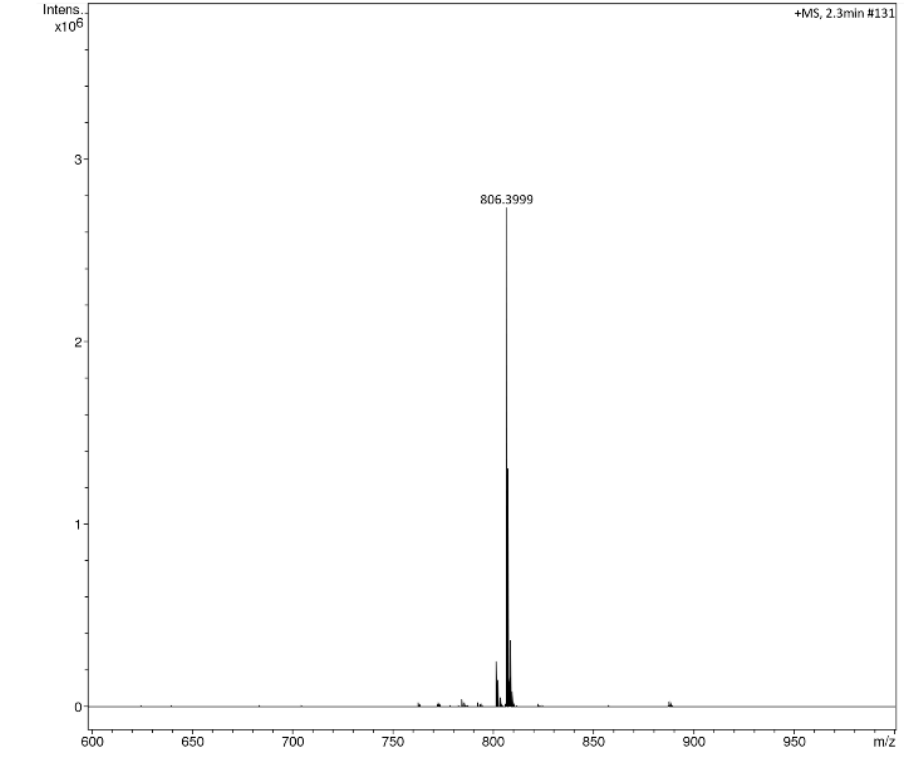
Figure 7. HRMS spectra from higher-collision dissociation of the [M + Na] + ions of fungal extract, ( a ) Fusarium sacchari NFCCI 4889 ( b ) F. tardicrescens NFCCI